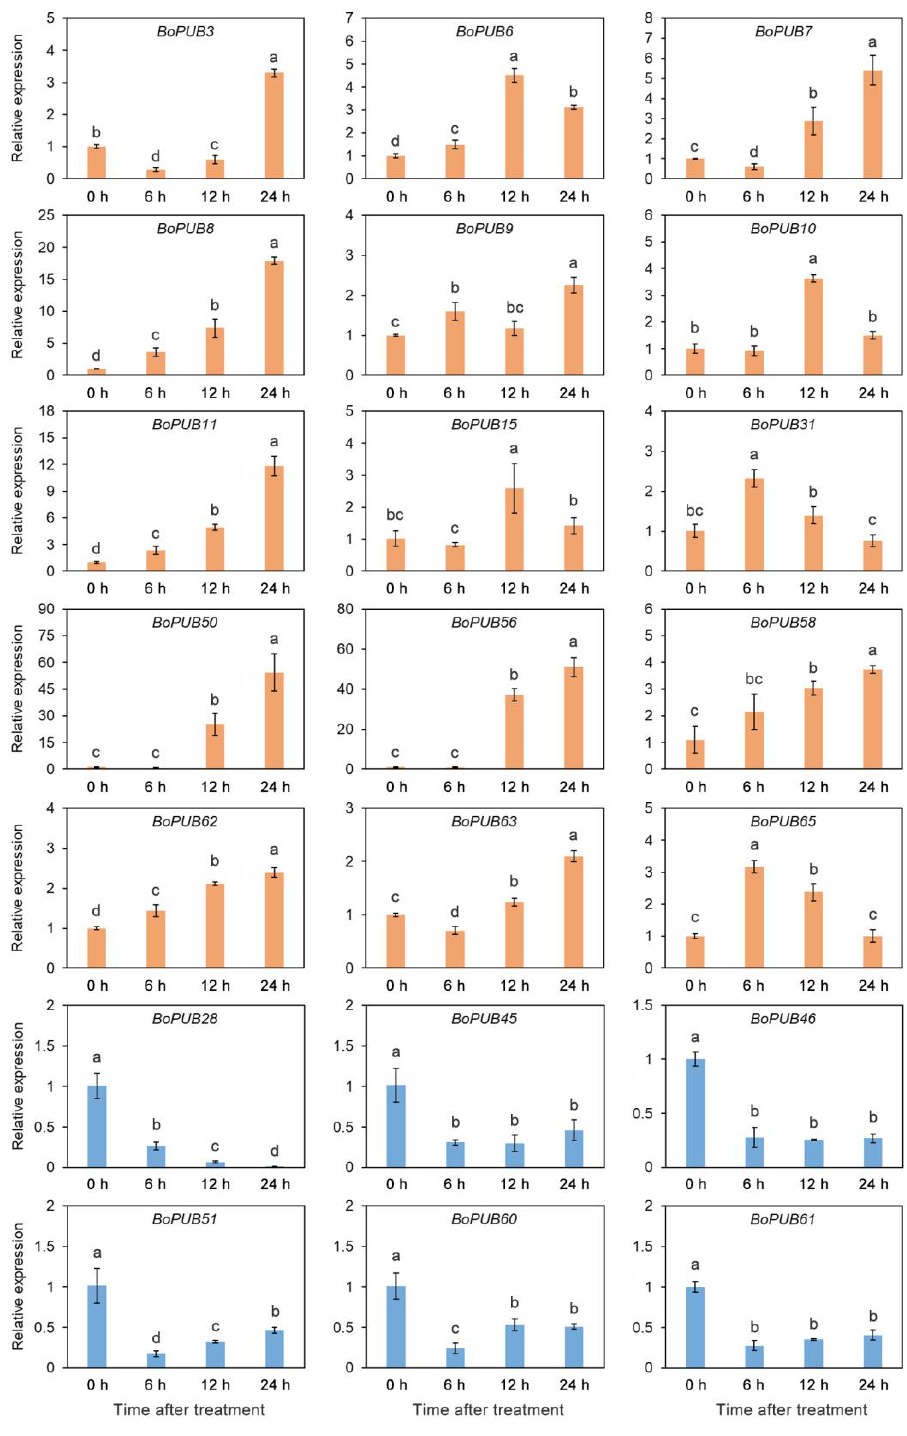
Figure 8. Expression profiles of BoPUB genes under low-temperature treatment. Total RNA was isolated from cabbage leaves after 4 °C treatment for 0 h, 6 h, 12 h, and 24 h, respectively. The extracted total RNA was then submitted to quantitative real-time PCR. The BoTUB6 gene was used as the internal control. Error bars represent the means ± standard deviation (SD) of three independent experiments. Significant differences were determined by Duncan’s multiple range test ( p < 0.05; one-way ANOVA). The lowercase letters above each bar indicate significant differences. Bars with the same lowercase letter represent no significant difference, and vice versa.